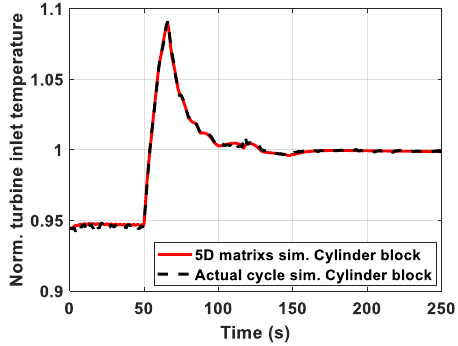
Figure 13. Turbine inlet temperature time history.